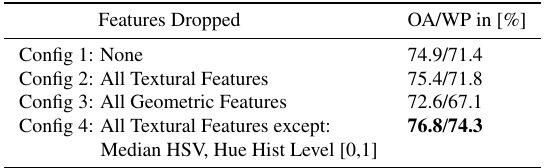
Table 4. Prediction results of Tile B for different compositions of the feature vector. The first column denotes all features that were removed with respect to X i,full . OA - Overall Accuracy, WP - Weighted Precision.